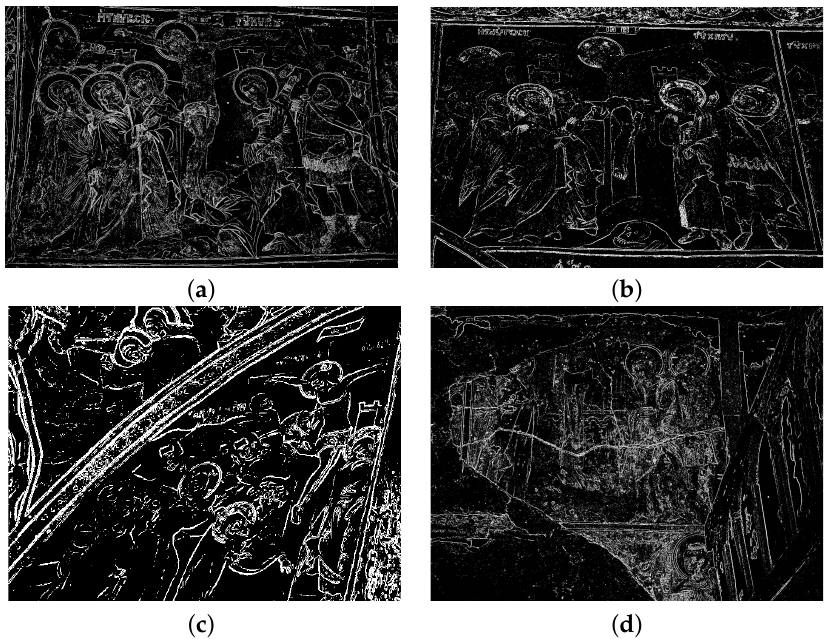
Figure 6. Crucifixion from a church ( a ) in Kourenta; ( b ) Negades; ( c ) Tsepelovo; and ( d ) Paidonia, in Epirus,